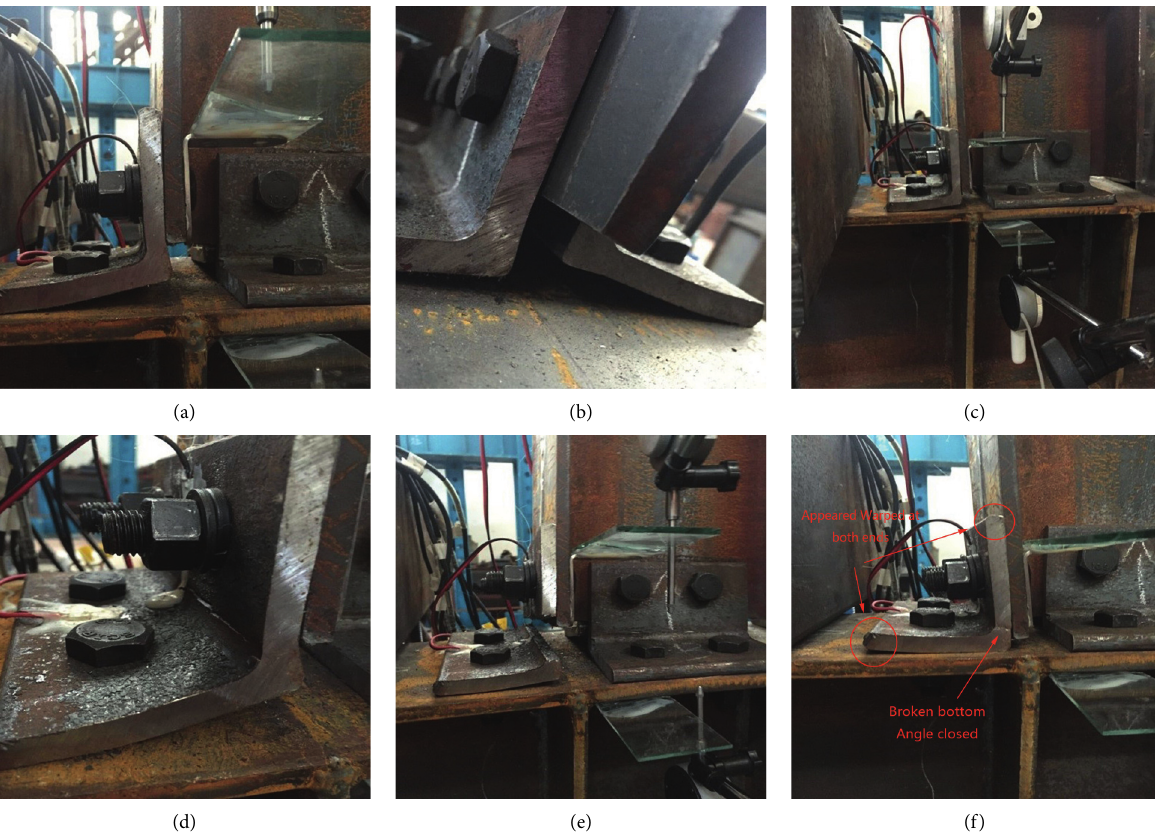
Figure 7: Deformation and failure form of SJB-3. (a) Seat angle warpage ( − 30mm). (b) Gap between upper angle steel and column flange (45mm). (c) Right gap between seat angle steel and column flange (45mm). (d) Seat angle steel deep crack ( − 45mm). (e) Seat angle steel fracture ( − 60 mm). (f) Broken seat angle closed and appeared warped at both ends